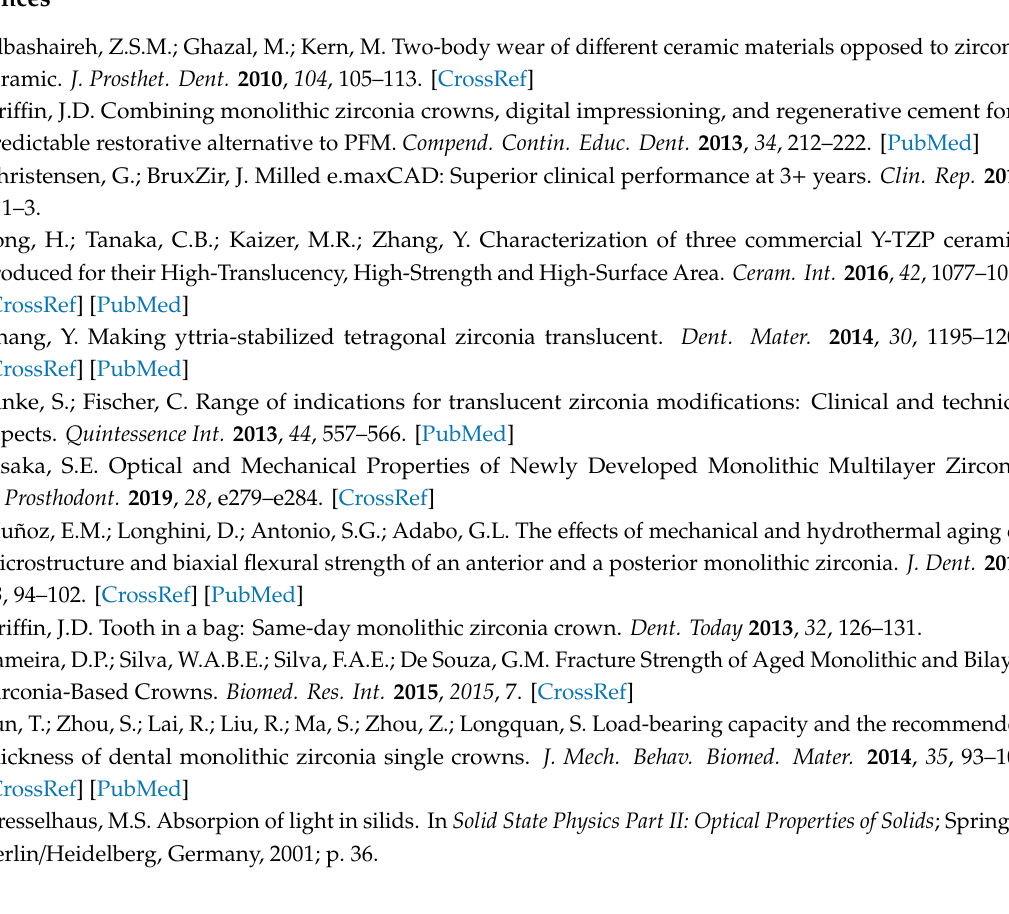
Table S1: Studies investigating optical properties of monolithic zirconia specimens / crowns. Studies are presented in ascending chronological order, Table S2: In vitro studies investigating the wear properties of monolithic zirconia. Studies are presented in ascending chronological order. Table S3: Commercial products listed in the studies included in the review, manufacturers and